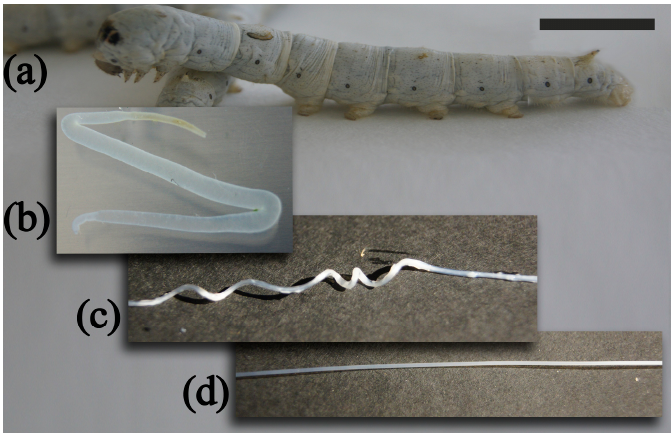
Figure 1. Production of silkworm gut fibers: ( a ) Caterpillar of a fifth instar silkworm; ( b ) Extracted glands immersed in a 2% acetic acid bath; ( c ) Part of the fiber forming a loop where the gland turns;